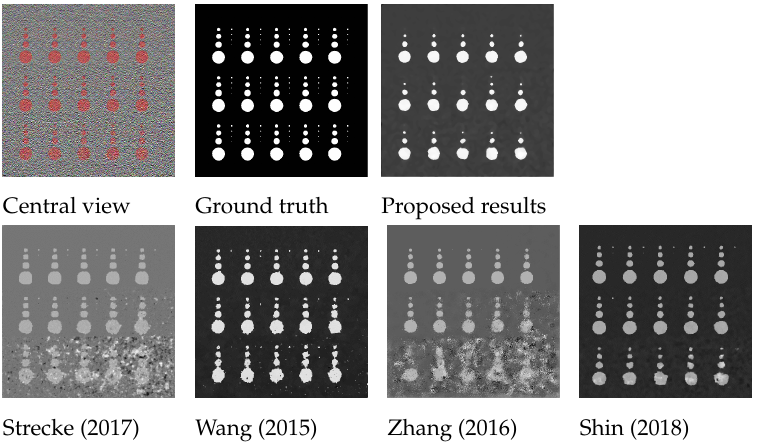
Figure 15. Visual comparison for the dot image of the proposed algorithm with Strecke et al. [9],